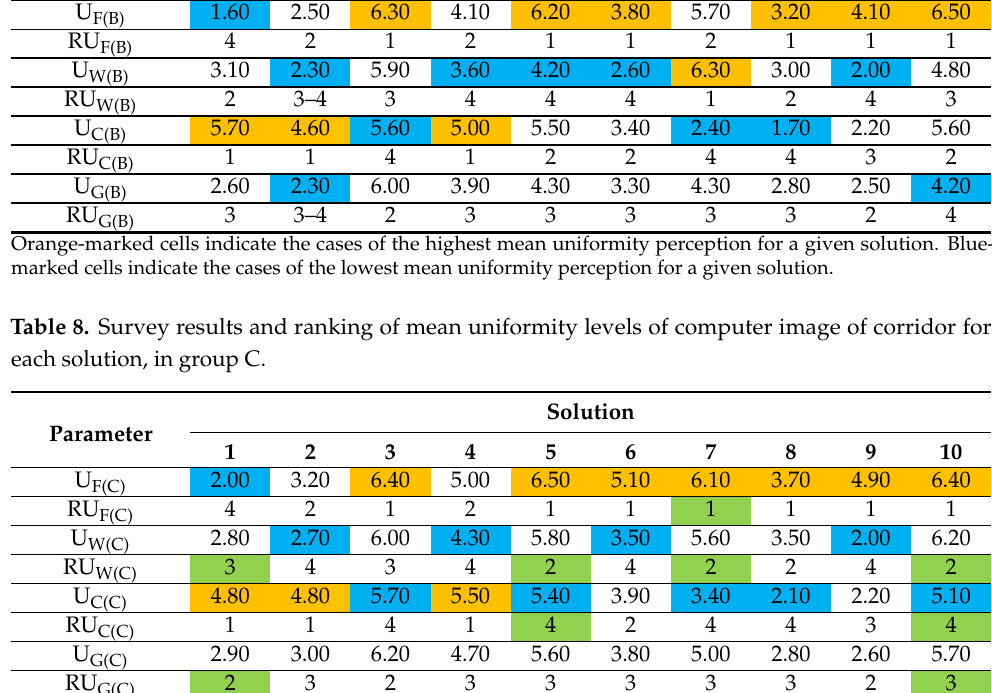
Orange-marked cells indicate the cases of the highest mean uniformity perception for a given solution. Blue- marked cells indicate the cases of the lowest mean uniformity perception for a given solution. Green marked cells indicate discrepancy in sequence of uniformity perception impressions in relation to group